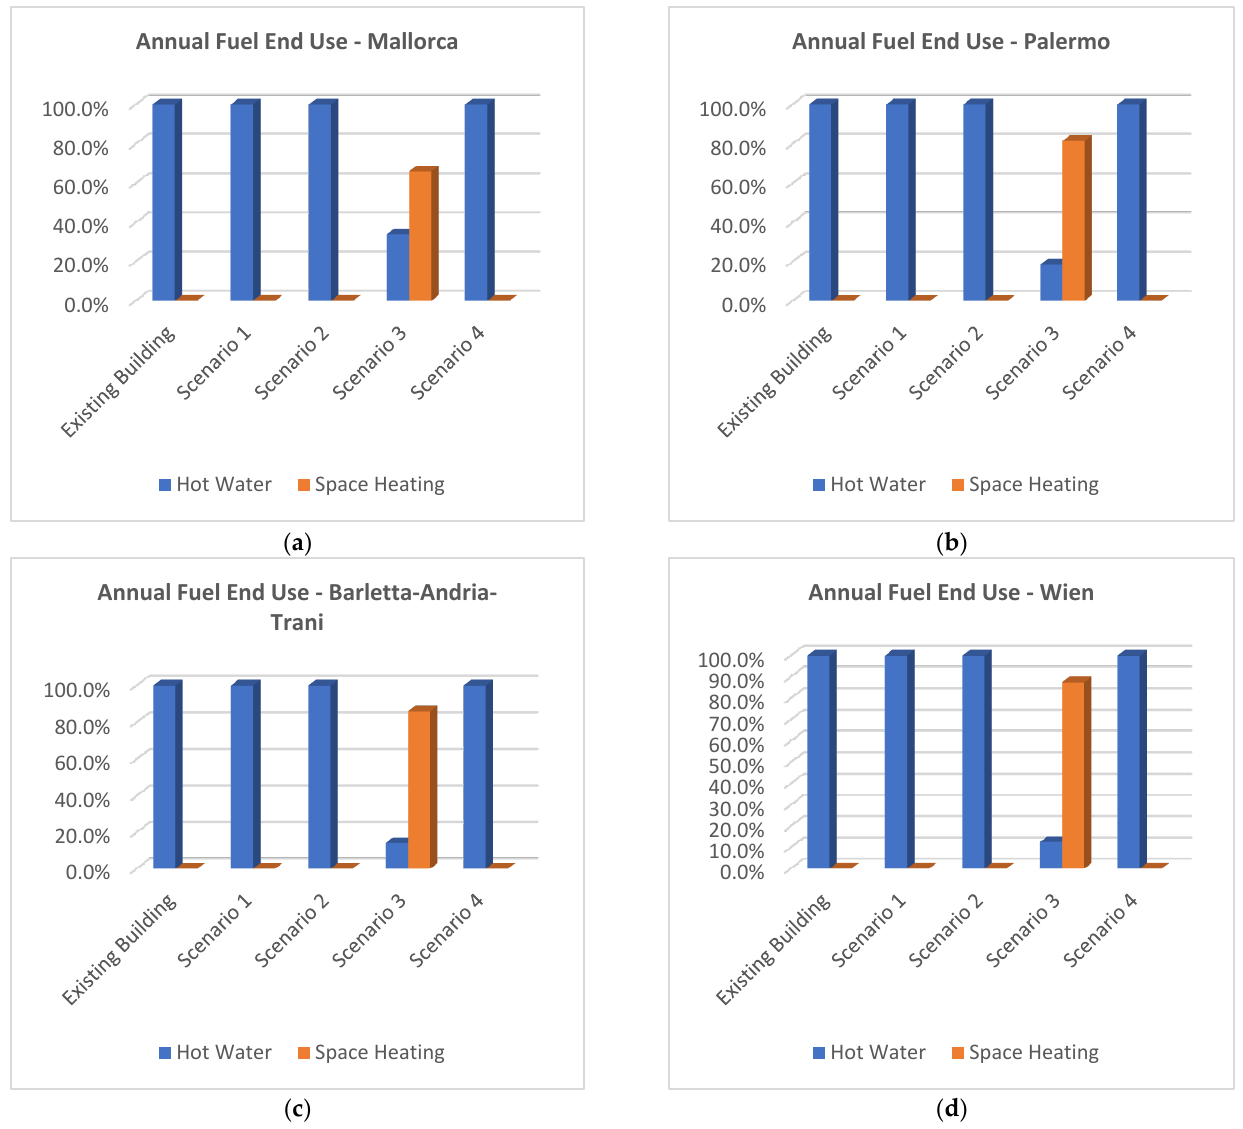
Figure 9. Annual Fuel End Use ( a ) in Mallorca, ( b ) in Palermo, ( c ) in Barletta-Andria-Trani, and ( d ) in Wien.